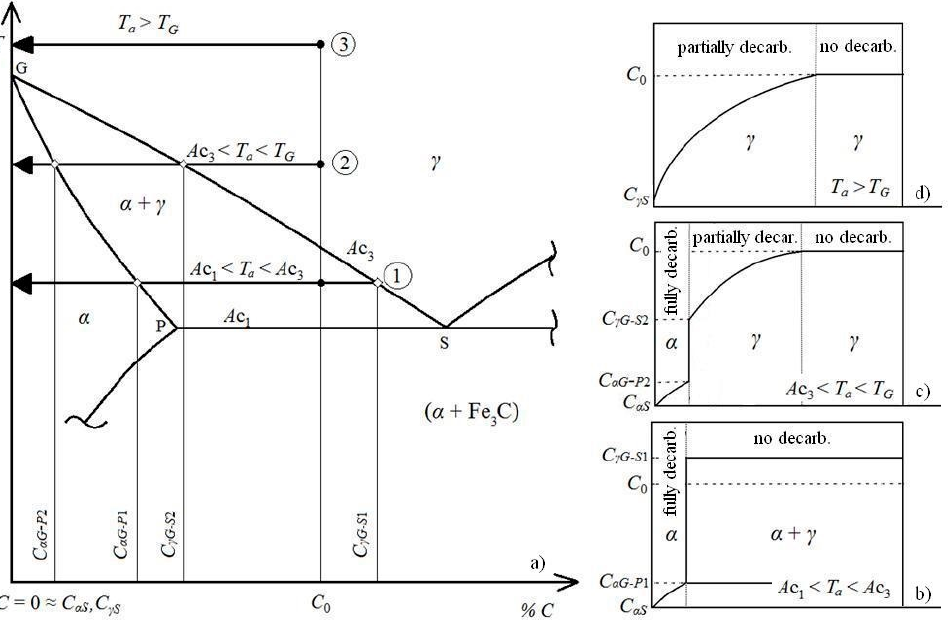
Figure 1. Surface decarburization of non-alloyed hypo-eutectoid steel during isothermal annealing at T > A C1 ; ( a ) Change in the microstructure; ( b − d ) concentration profiles of the carbon during the isothermal annealing for the different temperature ranges.